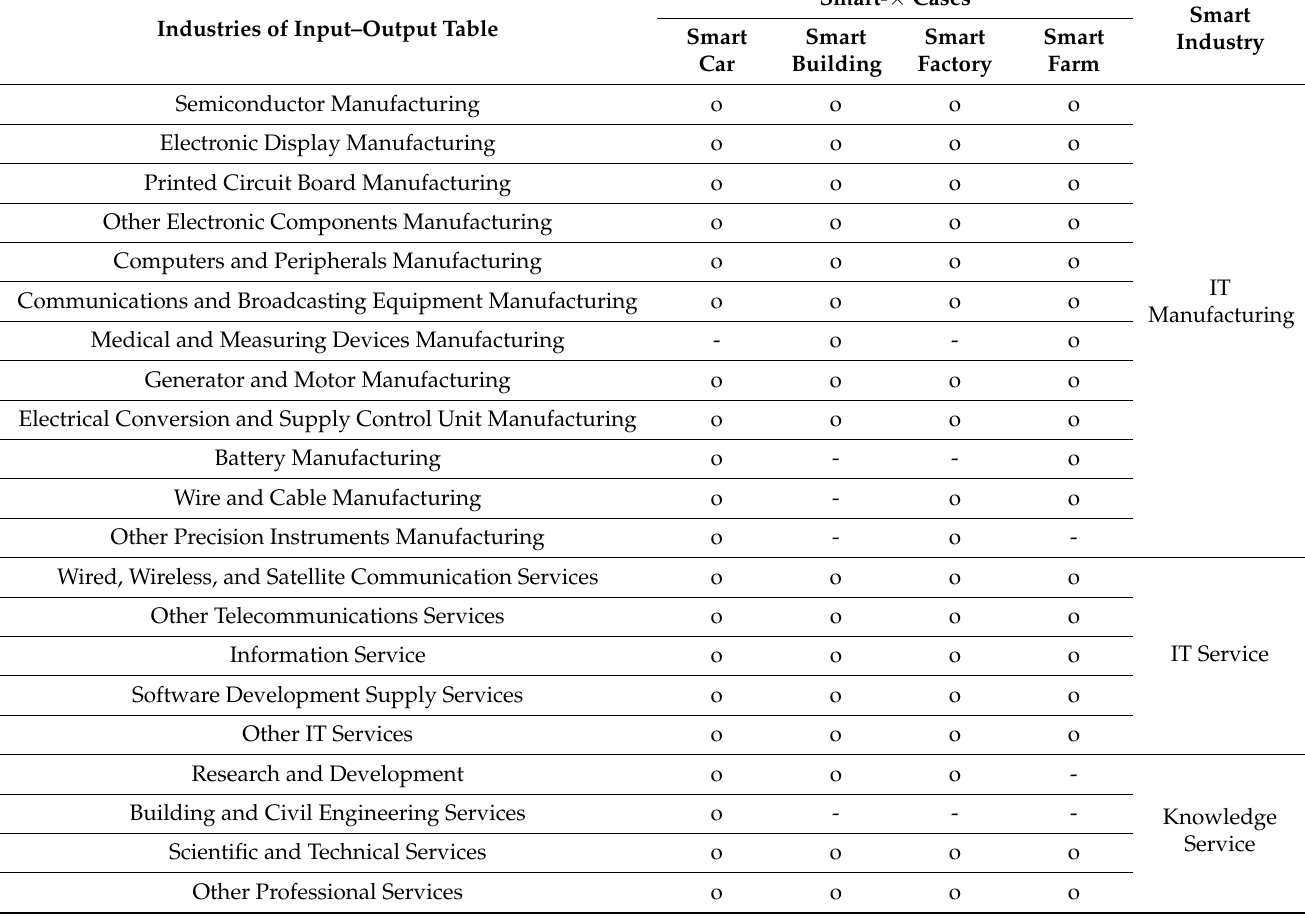
Table A1. Reclassification of industries using cases of